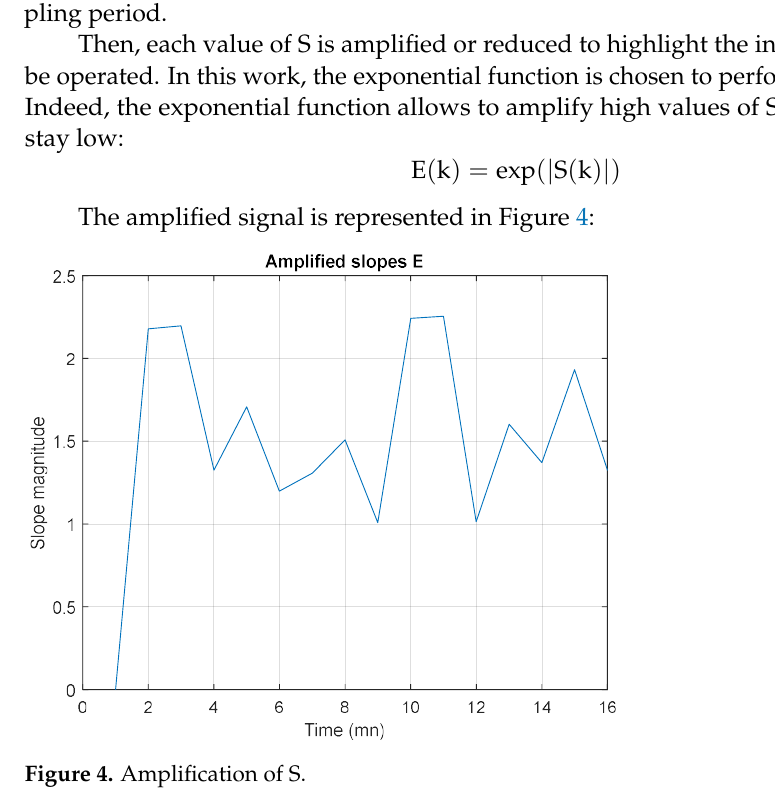
Figure 5 is an illustration of the class separation.